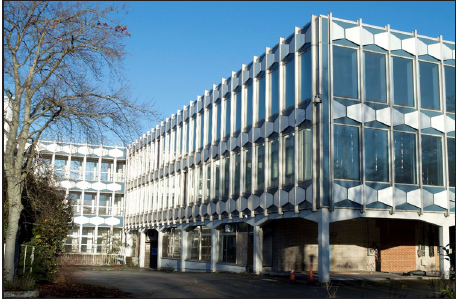
Figure 3: Walton Court, Surrey (Photo: ASE).